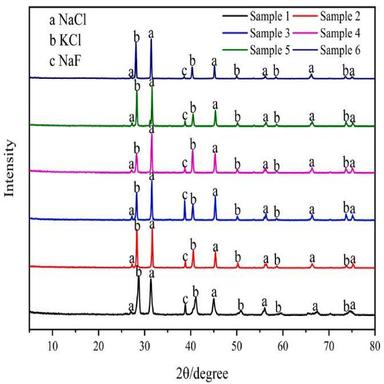
XRD patterns of BS and CPCMs.